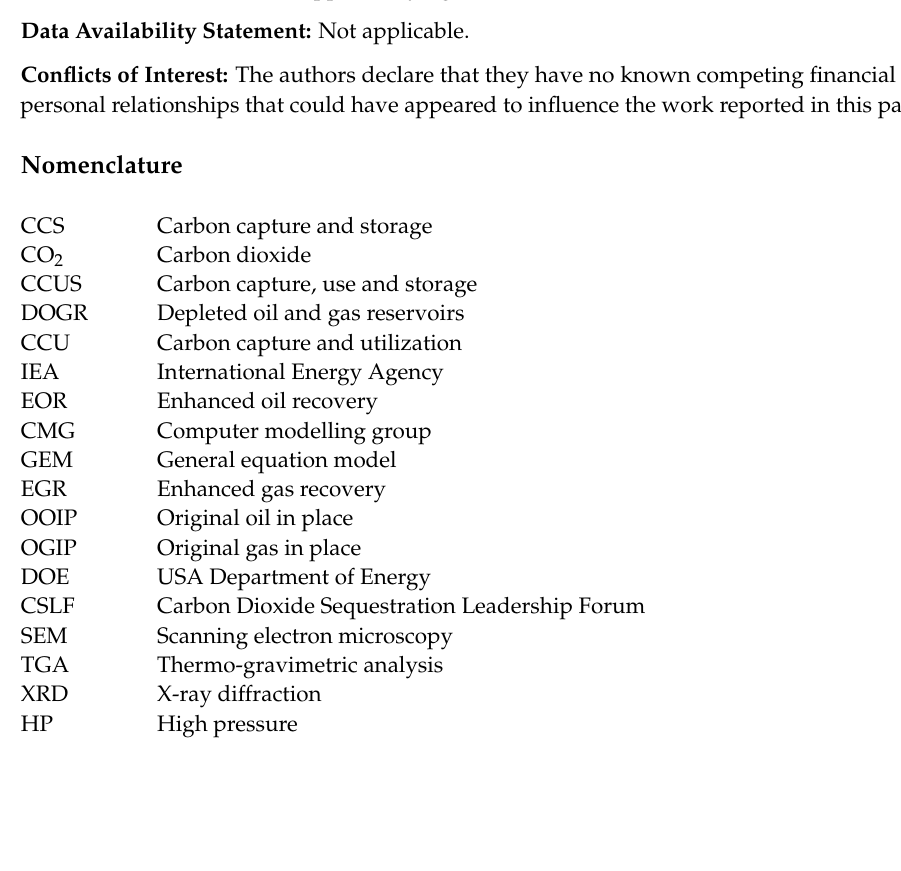
2 storage implementation in